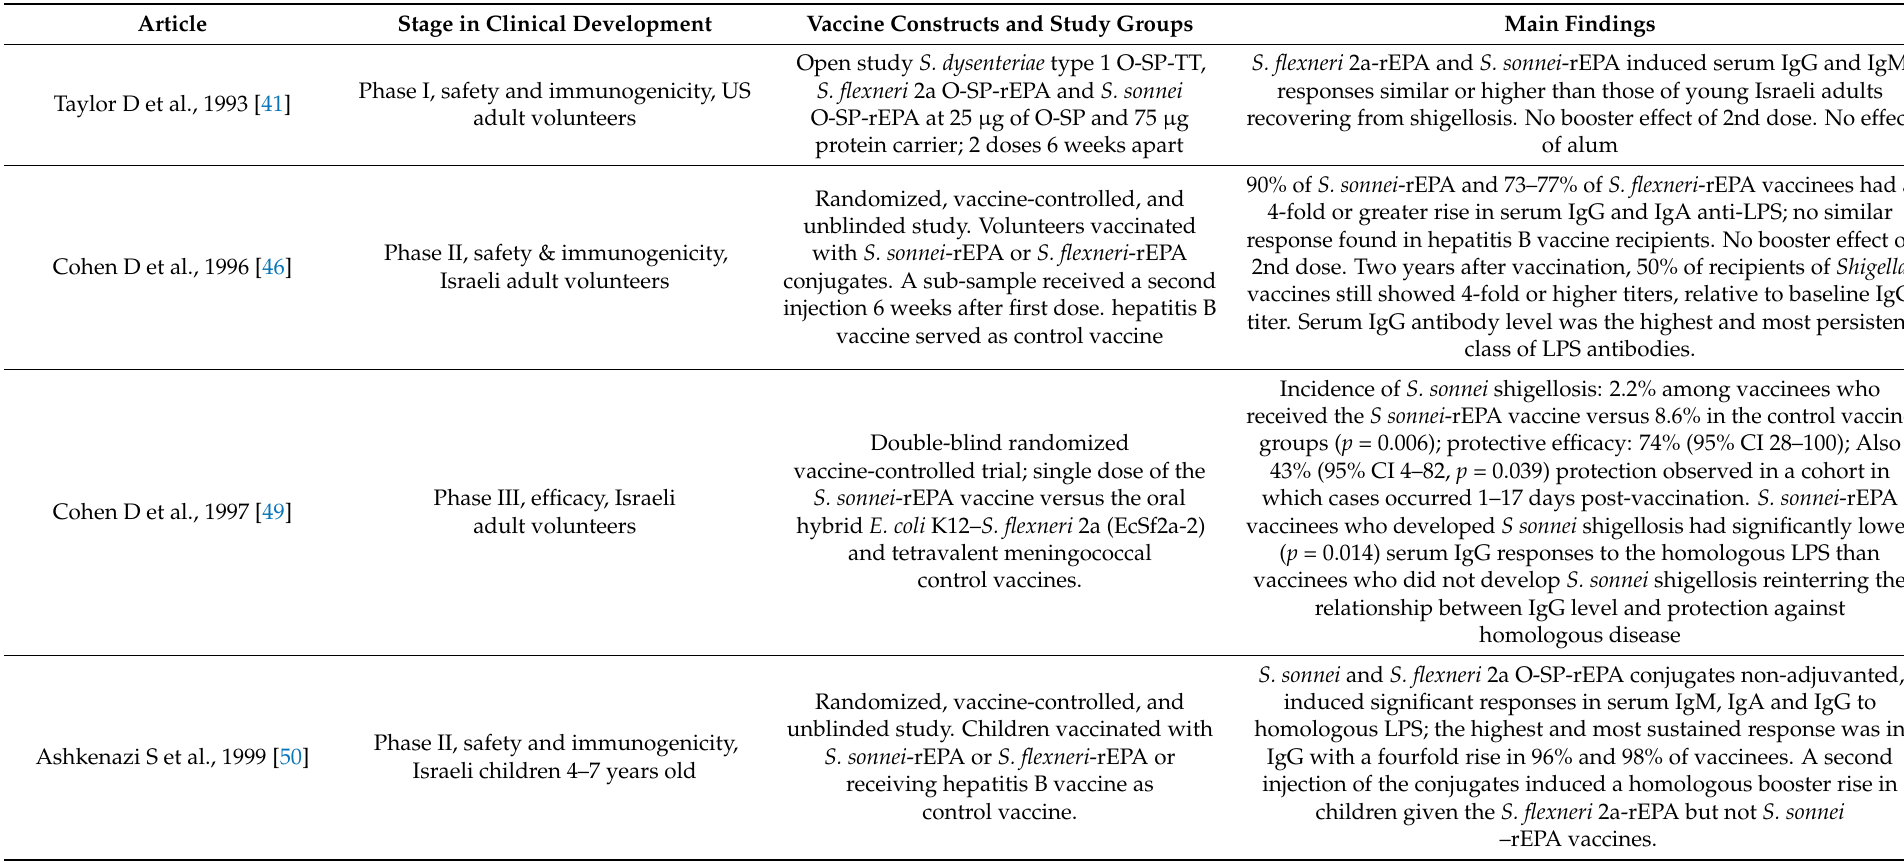
Table 1. Shigella conjugate constructs and immunogenicity and efficacy in age descending